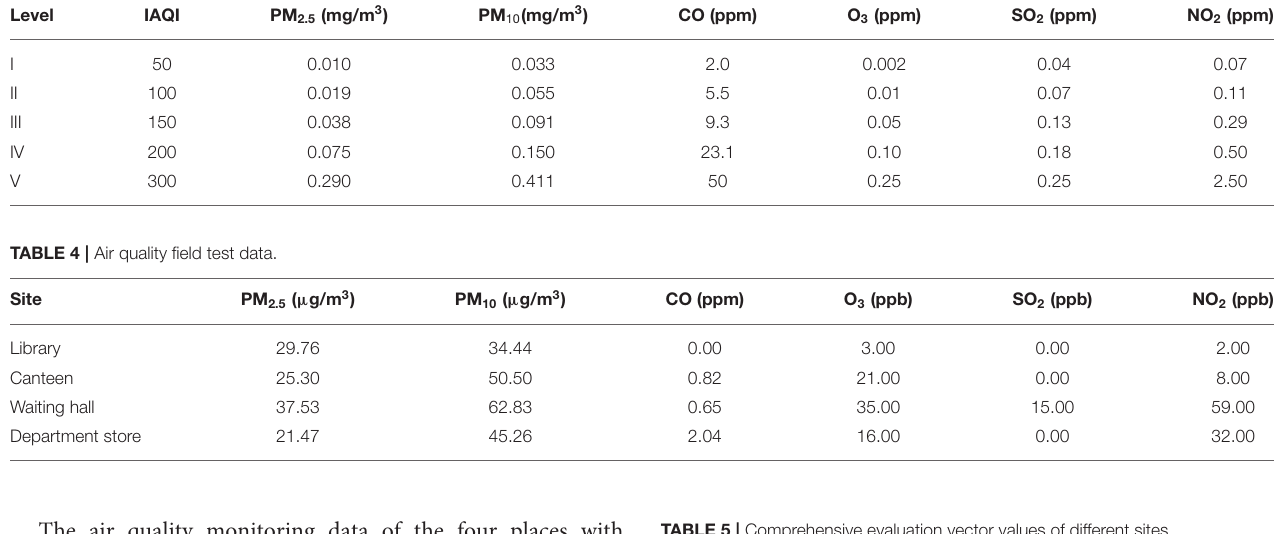
TABLE 5 | Comprehensive evaluation vector values of different